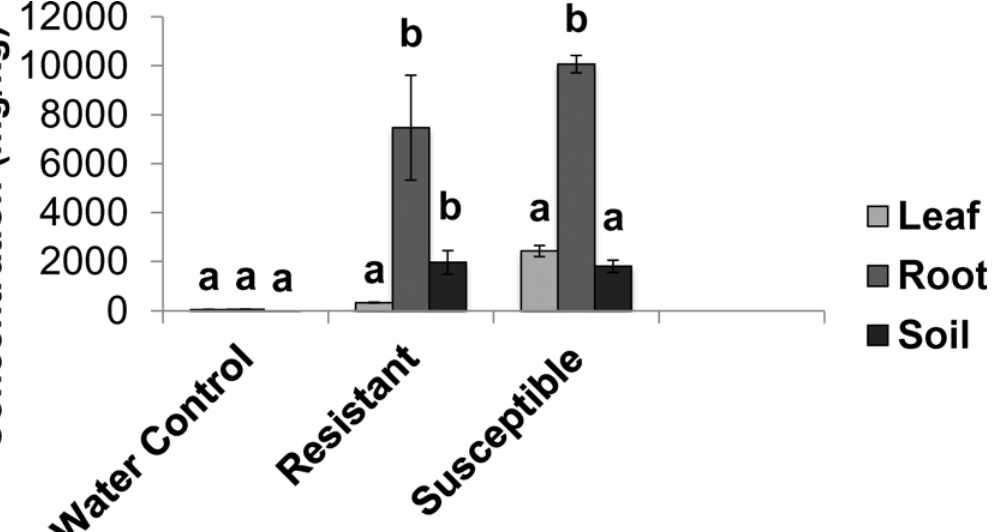
Fig 3. Concentration of nickel in leaves and roots of Betula papyrifera growing in soil containing 1,600 mg/kg of nickel. Means with a common subscript are not significantly different based on Tukey multiple comparison test (P (cid:3) 0.05). Error bars represent standard